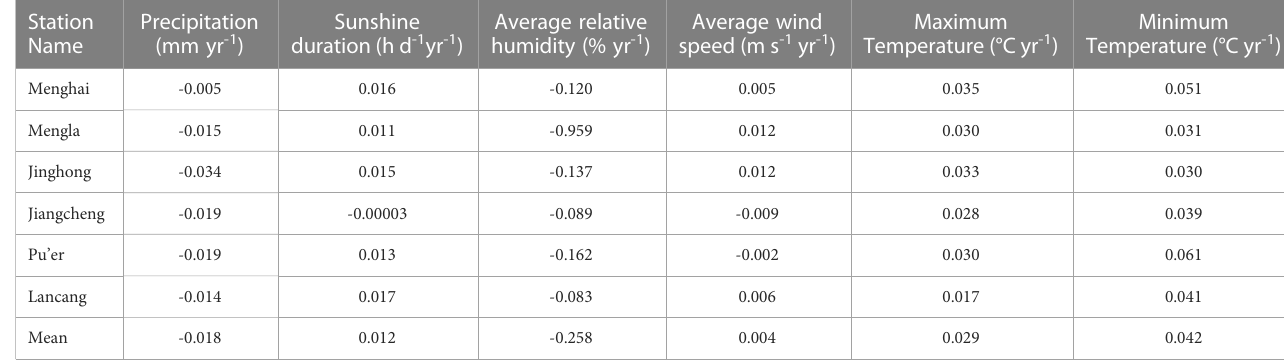
TABLE 3 Interannual variation trend of meteorological elements at each meteorological station.